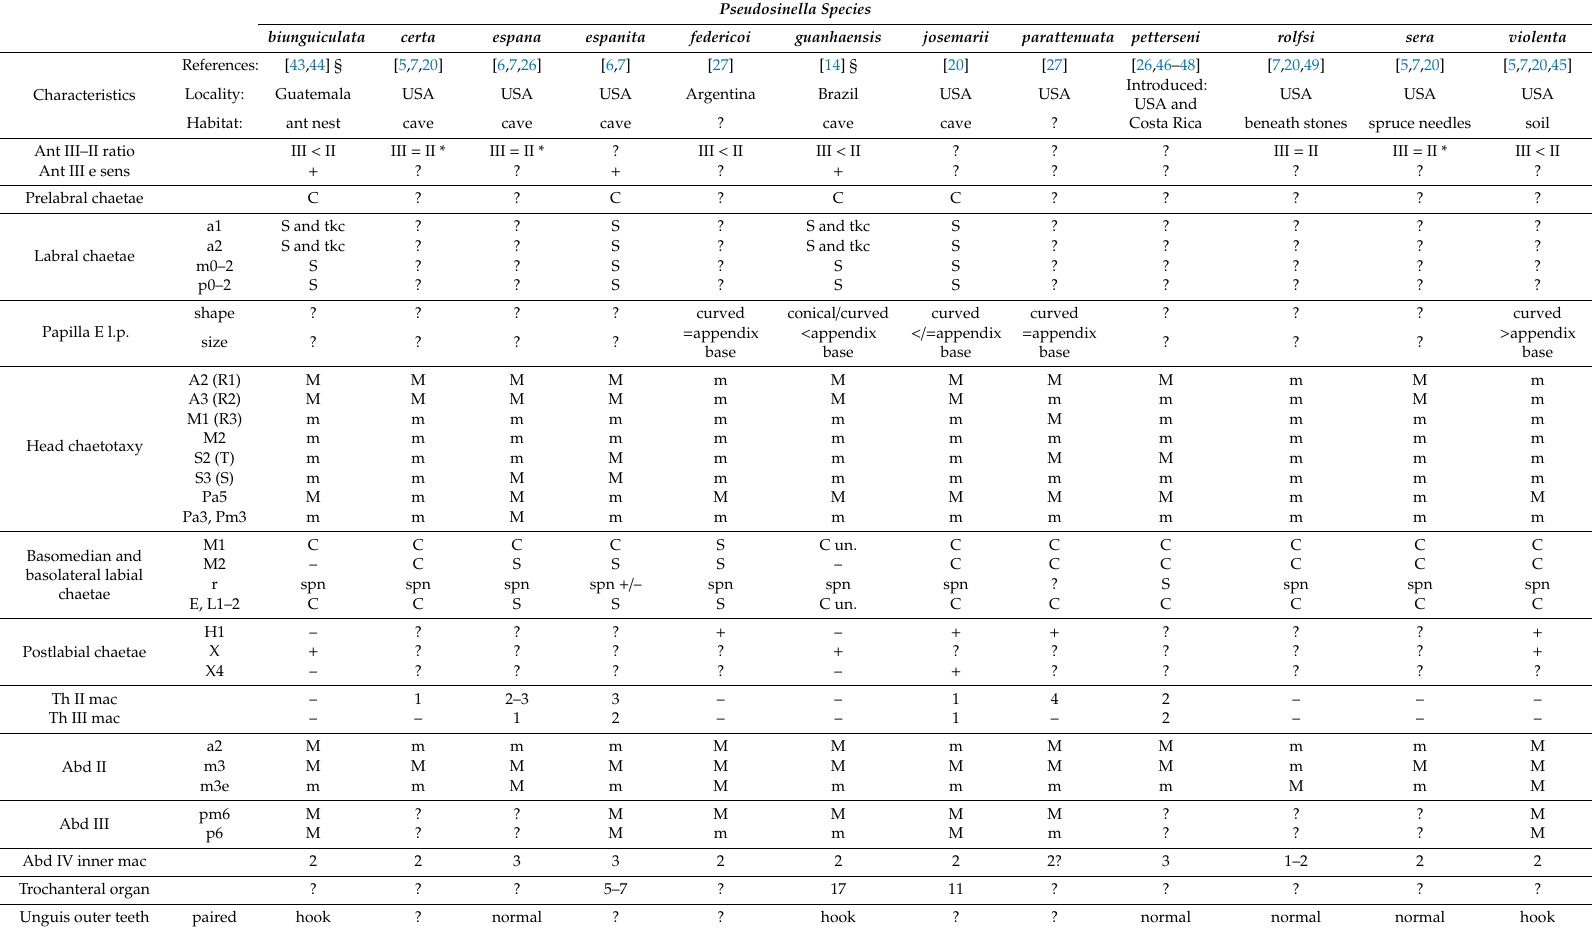
Table 2. Comparison (per side) among Pseudosinella species described from Americas with large tooth on pe lamella of unguiculus, basomedian labial field with a1–5 smooth, and devoid of pigments, eyes, apical bulb on Ant IV and unguis apical tooth (a.t.).